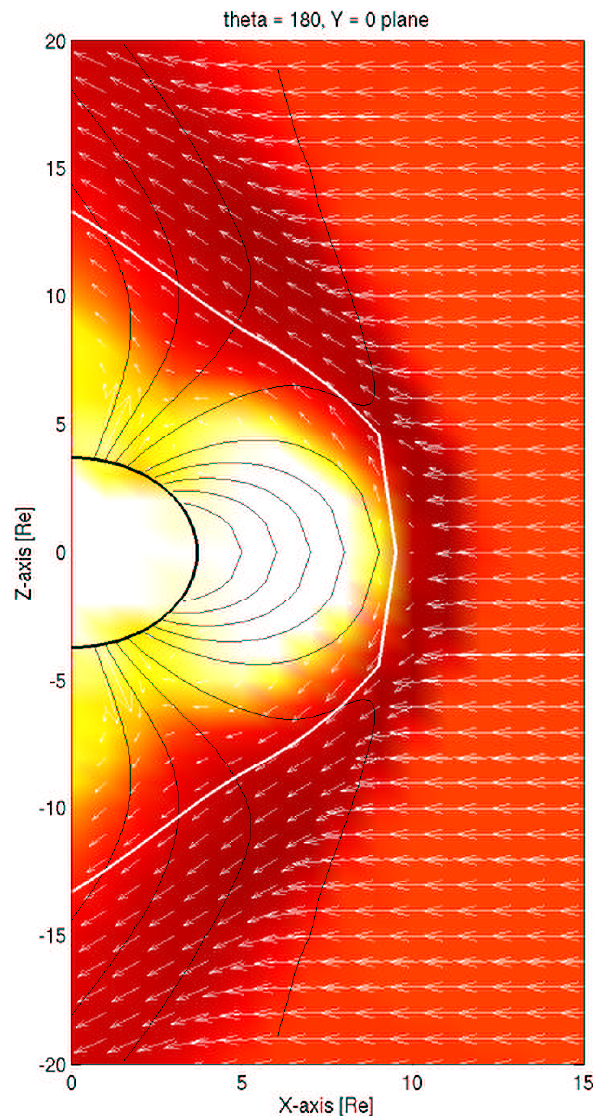
Fig. 4. GUMICS-4 plasma flow pattern (white arrows) at the vicin- ity of the magnetopause (white thick line) in XZ plane in Run #1 during due south IMF. Color coding shows the logarithm of density, where white is 3 #/cm 3 , and dark red 100 #/cm 3 . Magnetic field lines (black) end to 3.7 R E inner shell of MHD